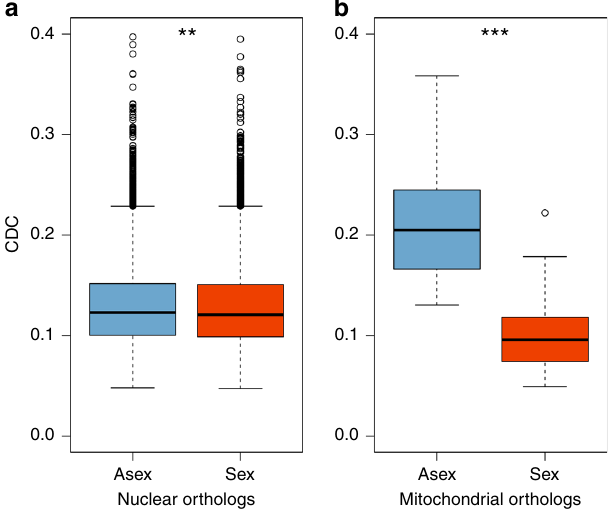
Fig. 3 Hydrophobicity scores at asexual and sexual terminal branches. The boxplots show hydrophobicity scores (HS) at three asexual (blue) and three sexual (red) terminal branches for ( a ) 3545 nuclear orthologous genes (involving 92,351 and 133,606 HS at asexual and sexual terminal branches, respectively) and ( b ) ten mitochondrial orthologous genes (involving 1494 and 2468 HS at asexual and sexual terminal branches, respectively). HS measures the strength in changes of hydrophobicity from ancestral to replacement amino acids and indicates the ‘ deleteriousness ’ of a nonsynonymous mutation. The lower the HS the stronger is the change in hydrophobicity and ‘ deleteriousness ’ of a nonsynonymous mutation. For nuclear orthologs, amino acids shifted to more dissimilar hydrophobicity at sexual branches (generalised linear mixed model z = 2.4, P = 0.017), indicating stronger ‘ deleteriousness ’ of nonsynonymous changes in sexual as compared to asexual oribatid mites. For mitochondrial orthologs, there was no difference (generalised linear mixed model z = 0.81, P = 0.421). Signi fi cant differences in HS are marked with an asterisk (* P < 0.05). Whiskers correspond to 1.5 times the interquartile range